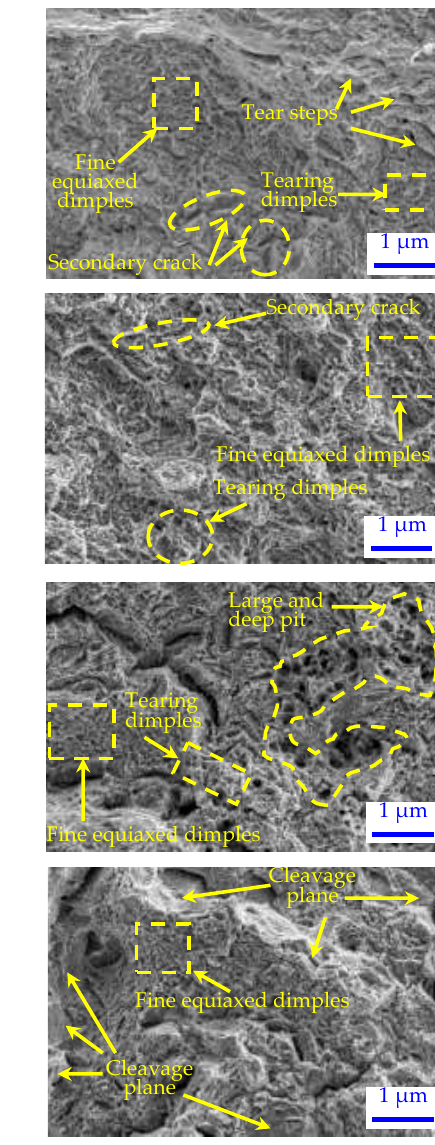
Figure 9. Micro and macro fracture morphologies of the steel